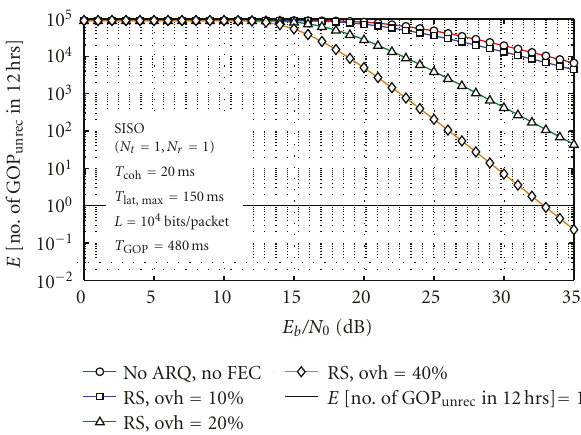
Figure 14: Average number of GOPs a ff ected by unrecoverable packet loss in 12 hours (Alamouti, N r = 2, ARQ). Figure 15: Average number of GOPs a ff ected by unrecoverable packet loss in 12 hours (SISO, RS).